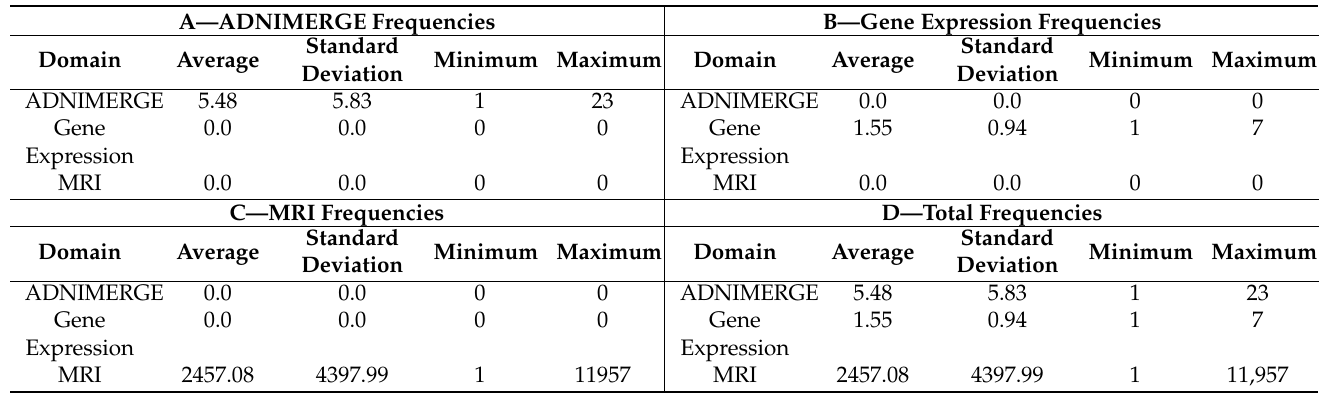
Table 4. Summarized correlated feature frequencies based on the maximally significant α